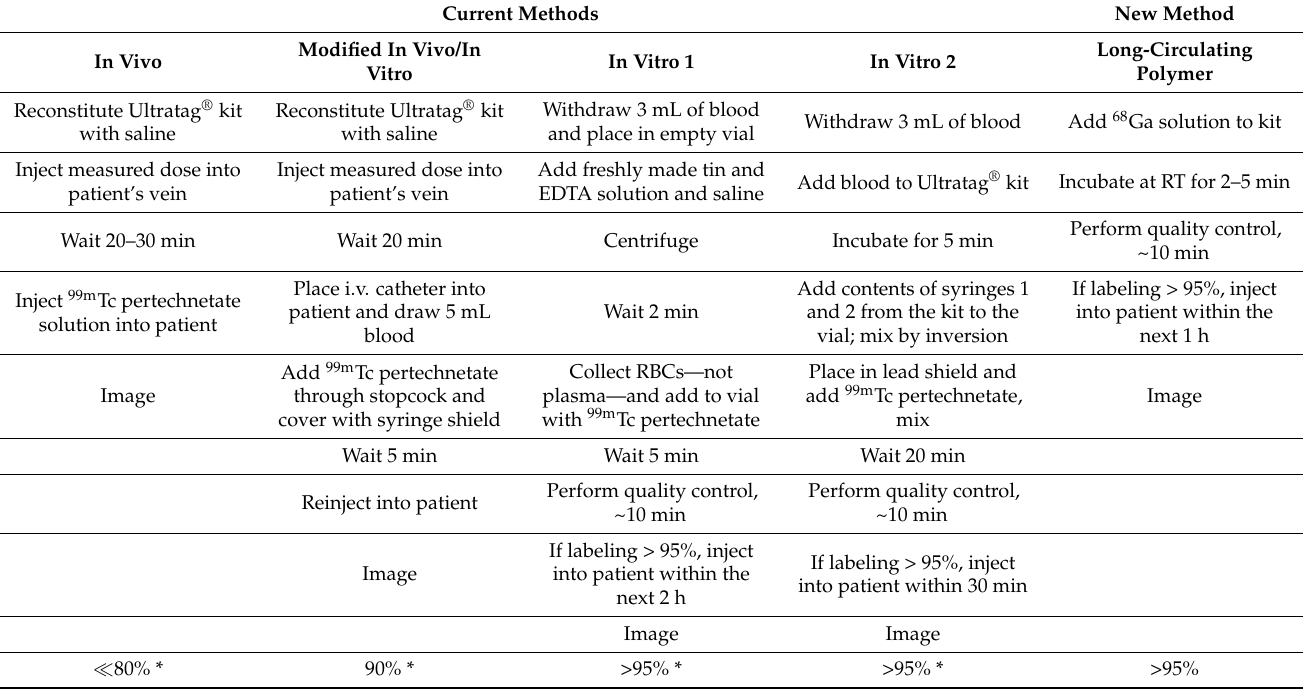
Table 2. Currently used clinical techniques for radiolabeling RBCs, compared to the method presented